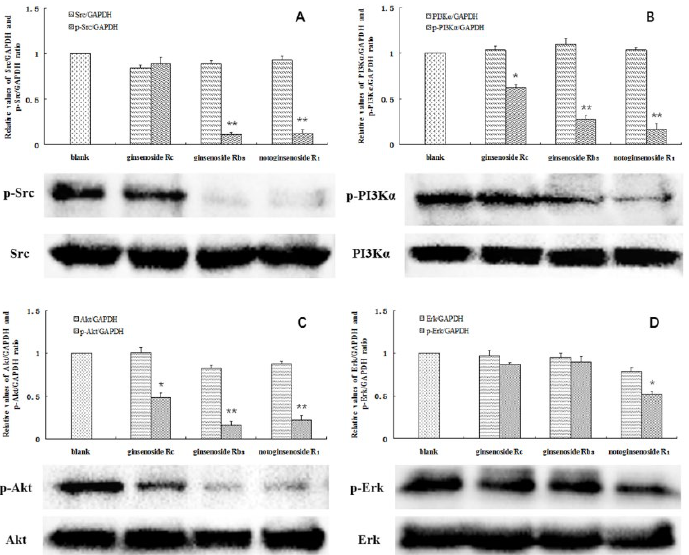
Figure 5. Total and phosphorylated SRC ( A ), PI3Kα ( B ), Akt ( C ), and ERK ( D ) in the A549 cells. Cells without a drug treatment were used as the blank group (relative ratio values were set to 1). * indicates p < 0.05, ** indicates p < 0.01.